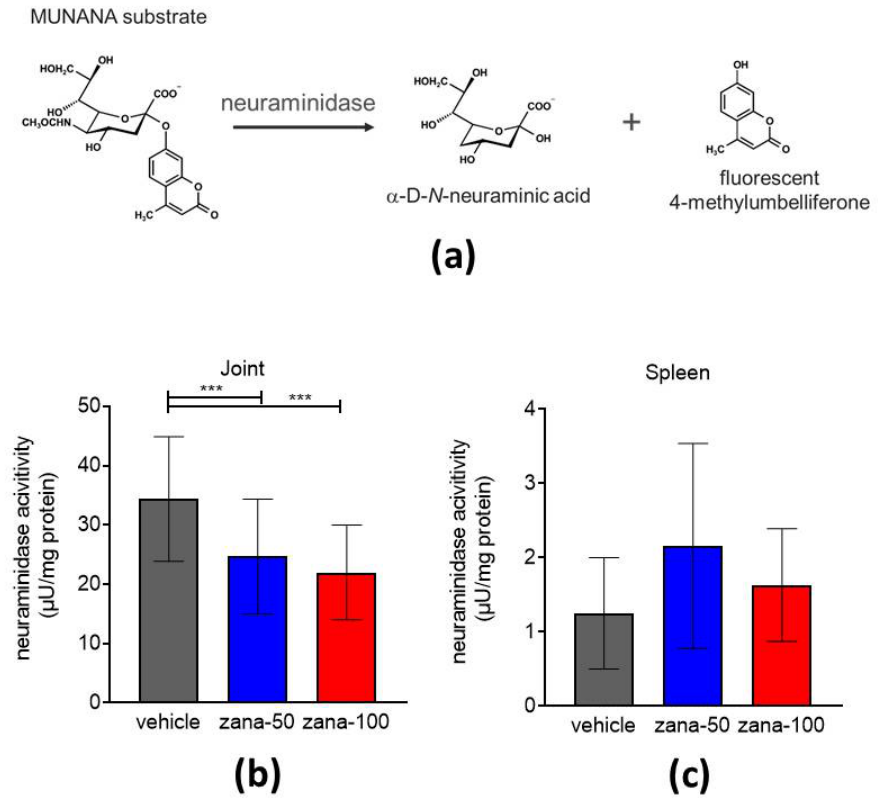
Figure 6. Reduced neuraminidase activity in arthritic joints upon zanamivir treatment. ( a ) 2′-(4-methylumbelliferyl)-α-D-N-acetylneuraminic acid (MUNANA) is catalyzed in the presence of neuraminidase into α-D-N-acetylneuraminic acid and fluorescent 4-methylumbelliferyl. Tissue extracts of CIA hind paws ( b ) and spleens ( c ) were prepared and applied to MUNANA assay. Neuraminidase activity was calculated as µU/mg total protein. Results are shown as ± standard deviation (±SD). *** p < 0.005. One-way ANOVA with Tukey’s multiple comparisons test was used for statistical analysis.